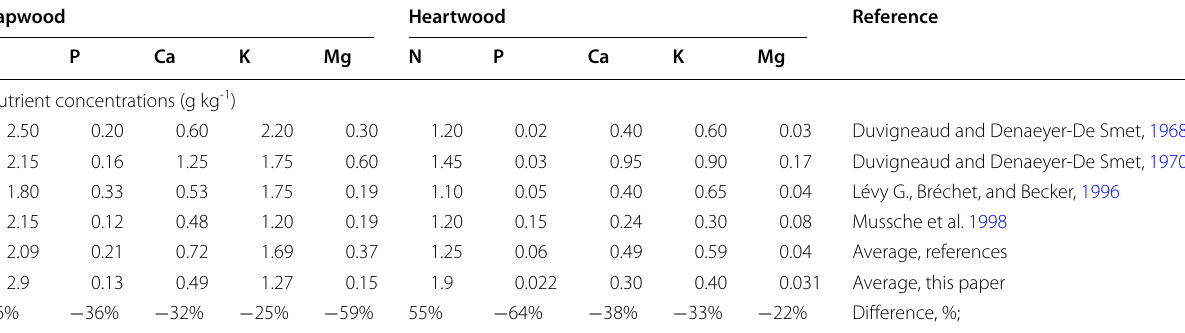
Table 15 Average nutrient concentrations in sapwood and heartwood (g kg -1 ) for common oak according to references and relative difference (%) with this paper (difference (%) this paper/average references – 1) x =